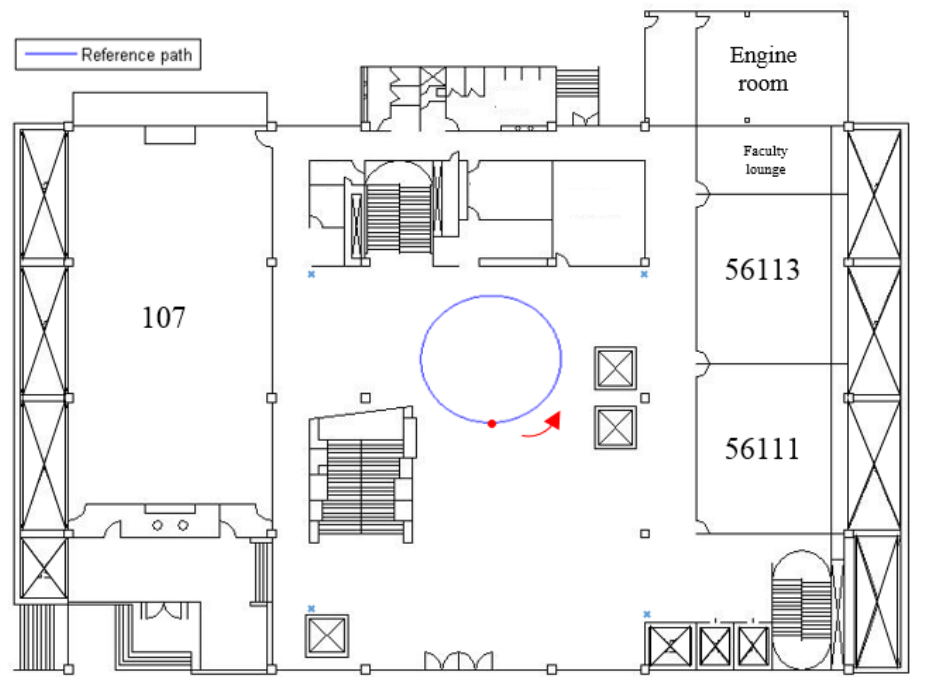
Figure 14. The circle path for the indoor positioning test in an indoor plane.